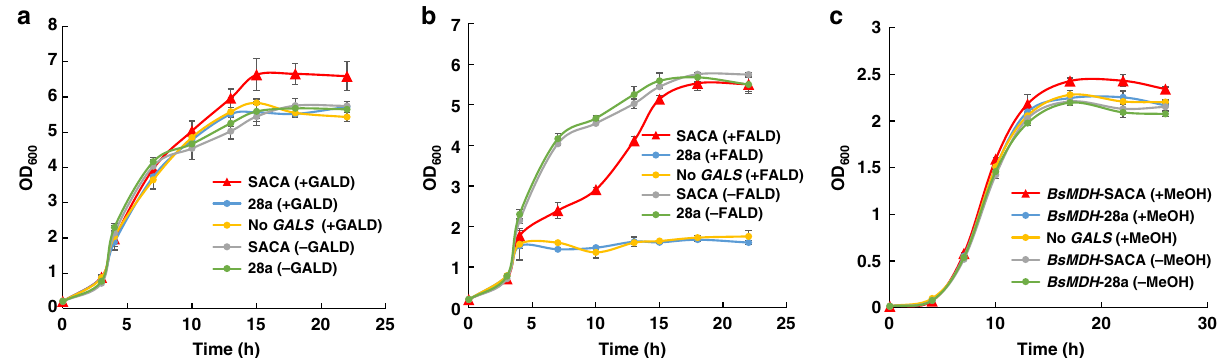
Fig. 7 Assessing the SACA pathway by cell growth. a Cell growth assays using 0.4 g L − 1 glycolaldehyde as supplemental carbon source. b Cell growth assays using 80 mg L − 1 formaldehyde as supplemental carbon source. c Cell growth assays using 8 g L − 1 methanol as supplementary carbon source. Cells initially were cultured in LB medium. IPTG was added to induce protein expression and then the supplemental carbon sources were added. OD 600 was detected at different time points. SACA the strain contains the vector GALS-ACPS-PT A-28a, 28a the strain contains the empty vector of 28a, BsMDH -SACA the strain includes both BsMDH -pCDF and GALS-ACPS-PTA -28a vectors, BsMDH -28a the strain contains both BsMDH -pCDF vector and the empty vector 28a, No GALS the strain contains all genes in the pathway except GALS , + adding supplemental carbon source, − without supplemental carbon source, glycolaldehyde (GALD), formaldehyde (FALD), methanol (MeOH). Error bars represent s.d. (standard deviation), n = 3. Source data are provided as a Source Data fi